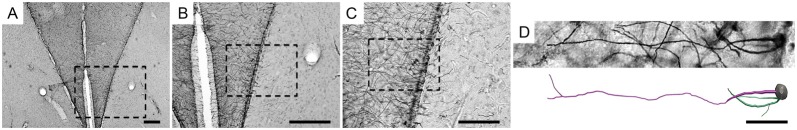
Low- and medium-power photomicrographs of the hippocampal V area (A–C) and a high-power 3D photomicrograph and digital reconstruction (D) of a radial astrocyte of a C. semipalmatus individual, captured on the coast of Bragança, Pará, Brazil. The square dotted line indicates the hippocampal V area containing the reconstructed radial astrocyte. Scale bars: (A) = 250 μm; (B) = 250 μm; (C) = 125 μm; (D) = 25 μm.